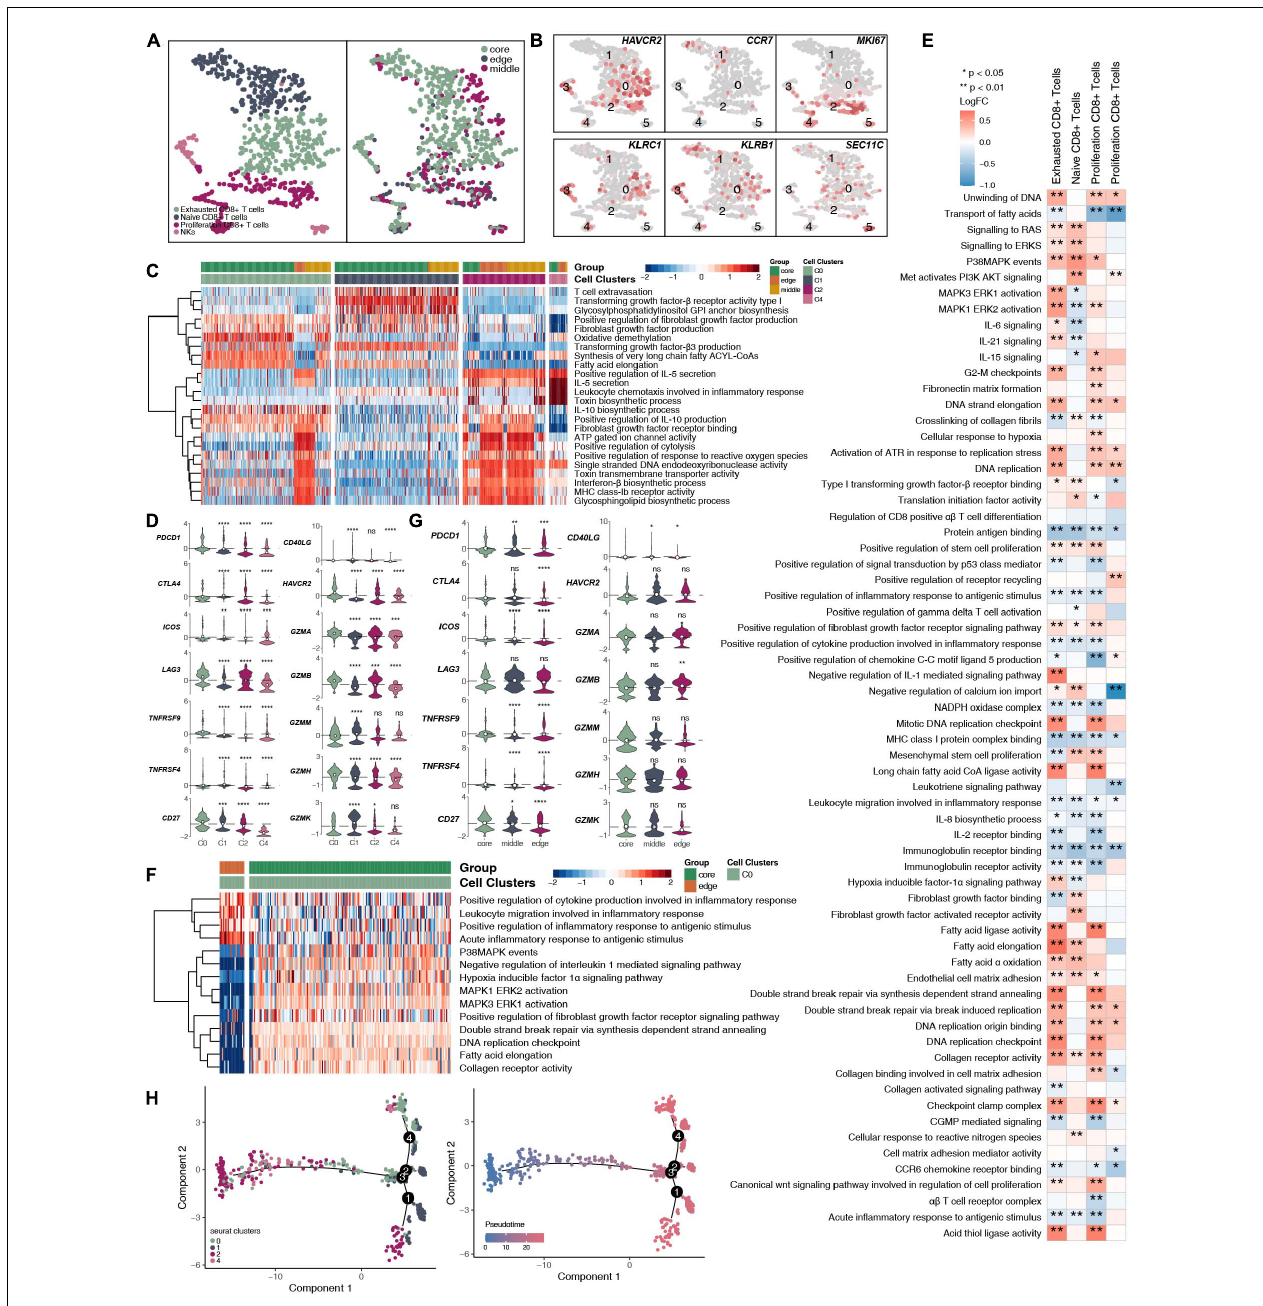
FIGURE 4 | CD8 + T cells/NK cells cluster in LUAD. (A) tSNE plot of 719 CD8 + T cells/NK cells, which are color-coded by their associated cluster or the sample location. (B) tSNE plot, which color-coded for the expression of marker genes for the cell types, as indicated. (C) Heatmap of the ssGSEA score, as estimated using gene sets from the MsigDB, for four CD8 + T cell clusters: exhausted CD8 + T cells (cluster 0), CD8 + naive T cells (cluster 1), proliferating CD8 + T cells (cluster 2), and proliferating CD8 + T cells (cluster 4). (D) Violin plots showing the smoothed expression distribution of selected genes involved in T cell activity and in immune checkpoints, stratified by CD8 + T cell clusters: exhausted CD8 + T cells (cluster 0), CD8 + naive T cells (cluster 1), proliferating CD8 + T cells (cluster 2), and proliferating CD8 + T cells (cluster 4). (E) Heatmap depicting the mean differences in pathway activities scored per cell by GSVA between tumor core and tumor edge across the exhausted CD8 + T cells (cluster 0), CD8 + naive T cells (cluster 1), proliferating CD8 + T cells (cluster 2), and proliferating CD8 + T cells (cluster 4). The x -axis of the heatmap indicates different CD8 + T cell clusters, and the y -axis indicates pathway activities scored per cell by GSVA. Each square represents the fold change or difference in each indicated pathway activity scored per cell by GSVA between the tumor core and tumor edge across the exhausted CD8 + T cells (cluster 0), CD8 + naive T cells (cluster 1), proliferating CD8 + T cells (cluster 2), and proliferating CD8 + T cells (cluster 4). Red indicates upregulation, while blue indicates downregulation. (F) Heatmap of the ssGSEA score, as estimated using gene sets from MsiDB, between the tumor core and tumor edge across the exhausted CD8 + T cells (cluster 0). (G) Violin plots showing the smoothed expression distribution of selected genes involved in T cell activity and in immune checkpoints between the tumor core and tumor edge across the exhausted CD8 + T cells (cluster 0). (H) The cell trajectory of CD8 + T cells. * P < 0.05; ** P < 0.01; *** P < 0.001; **** P < 0.0001.